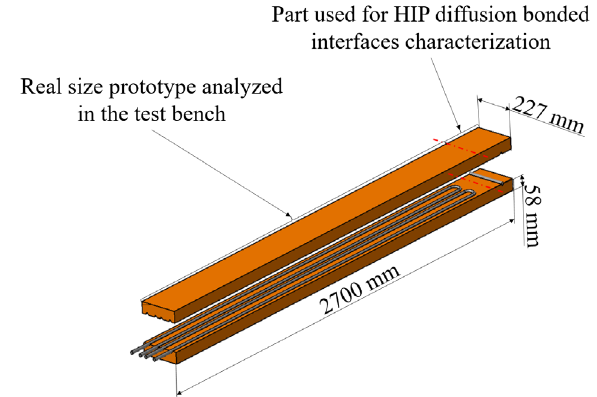
FIG. 1. Cross section of the new generation SPS internal dump core, TIDVG#5. FIG. 2. Design details of the real size cooling plate